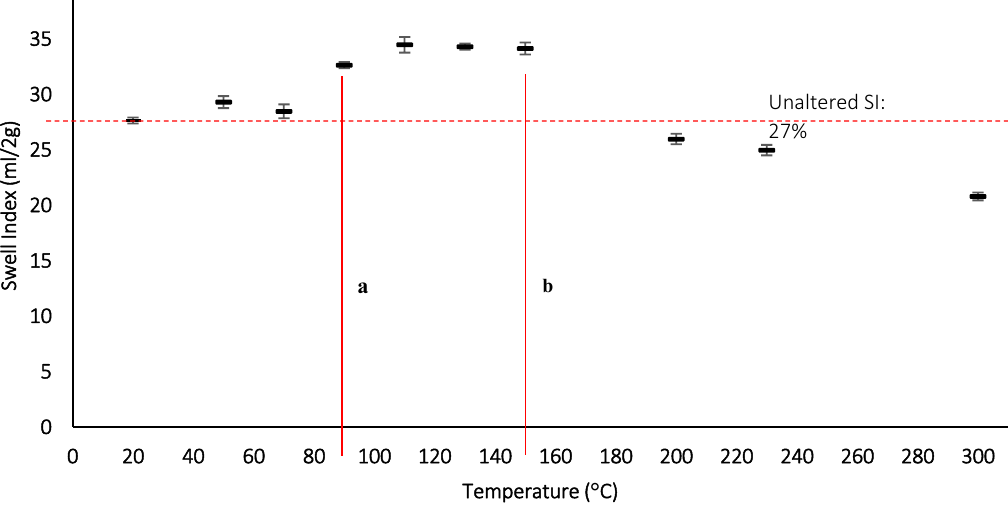
Figure 12. Swell index measurements with increasing thermal exposure after 24 h, a: lower temperature point where SI increases, b: upper temperature point where after which the SI reduces.